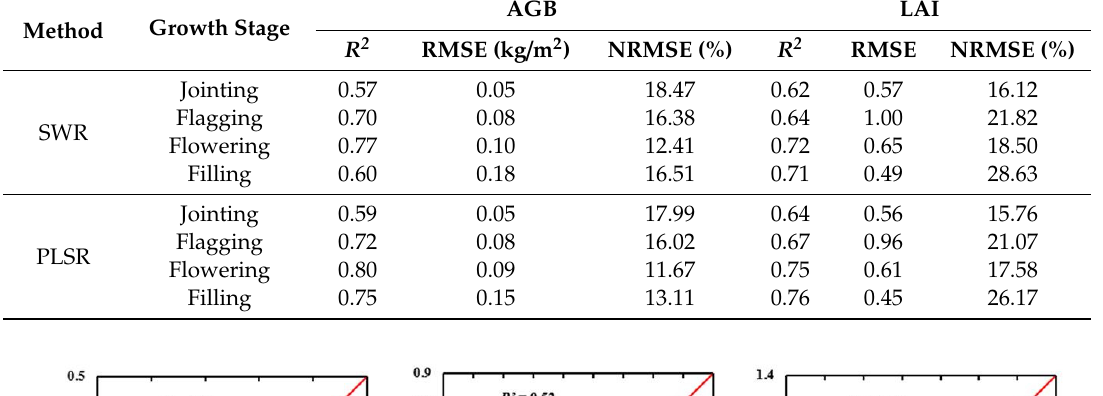
of winter wheat, the fit, accuracy, and model stability of the estimates of AGB and LAI obtained using the PLSR method are superior to those of the estimates obtained using the SWR method.